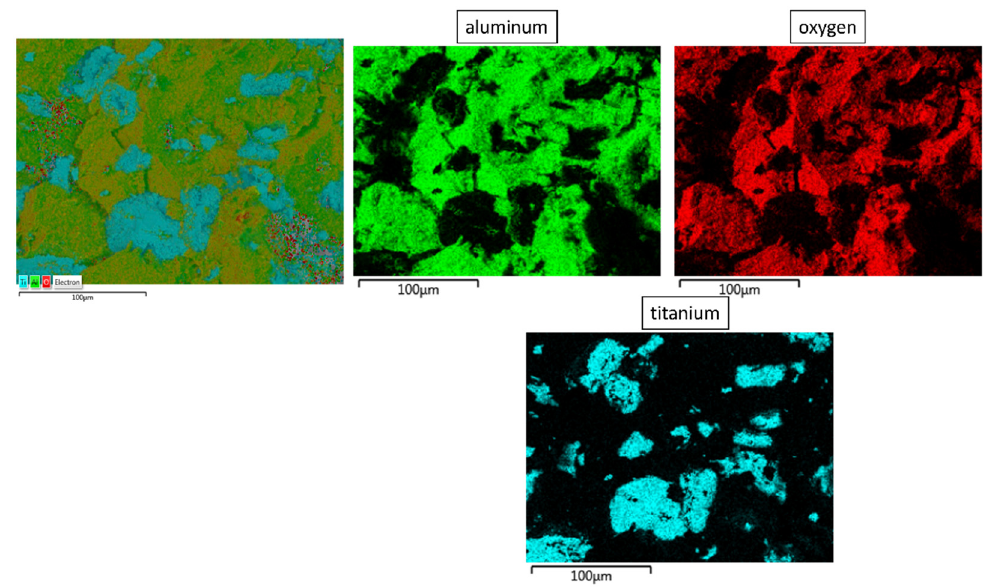
Figure 8. SEM image (BSE mode) of sintered Al 2 O 3 /Ti sample.